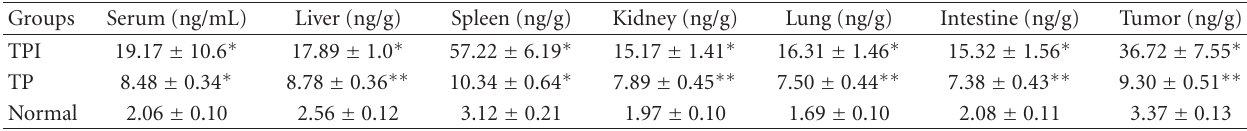
Table 4: Expression level of IL-2 protein in tissues of mice (mean ±